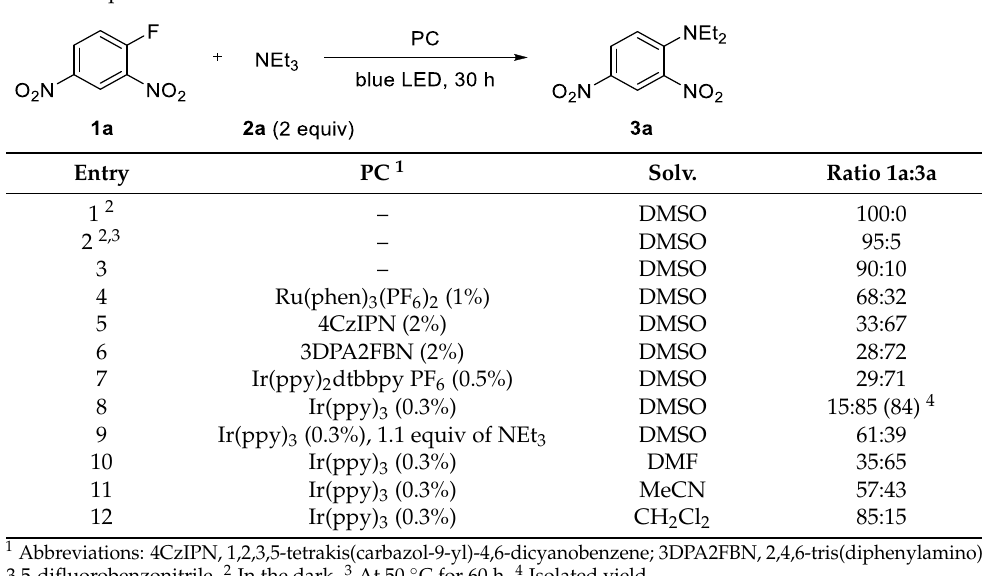
Table 1. Optimization studies.